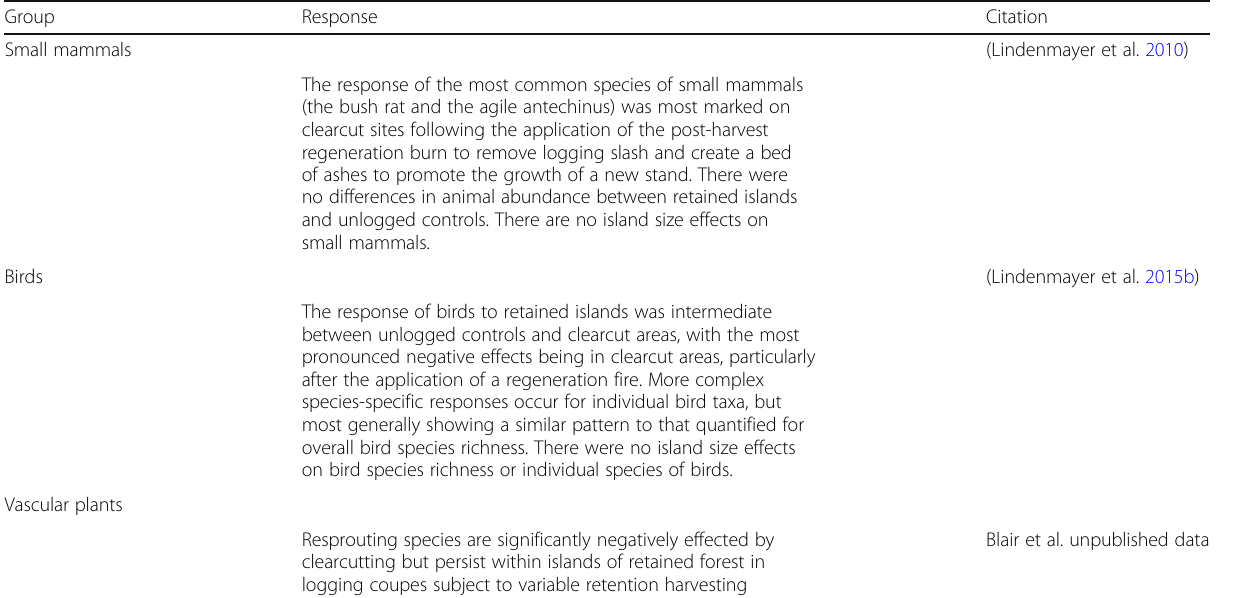
Table 1 Summary of general findings for different groups in the variable retention harvesting experiment in the Central Highlands of Victoria, south-eastern